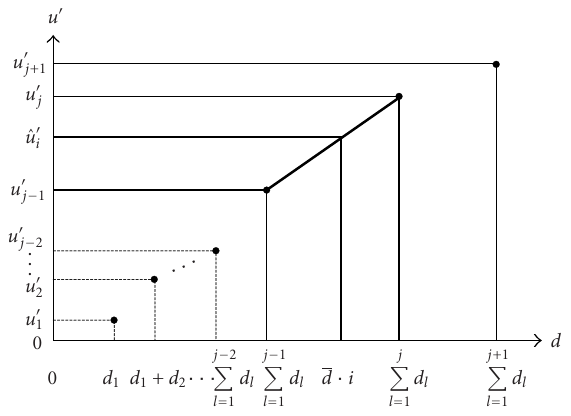
Figure 7: Example of Procedure 1.